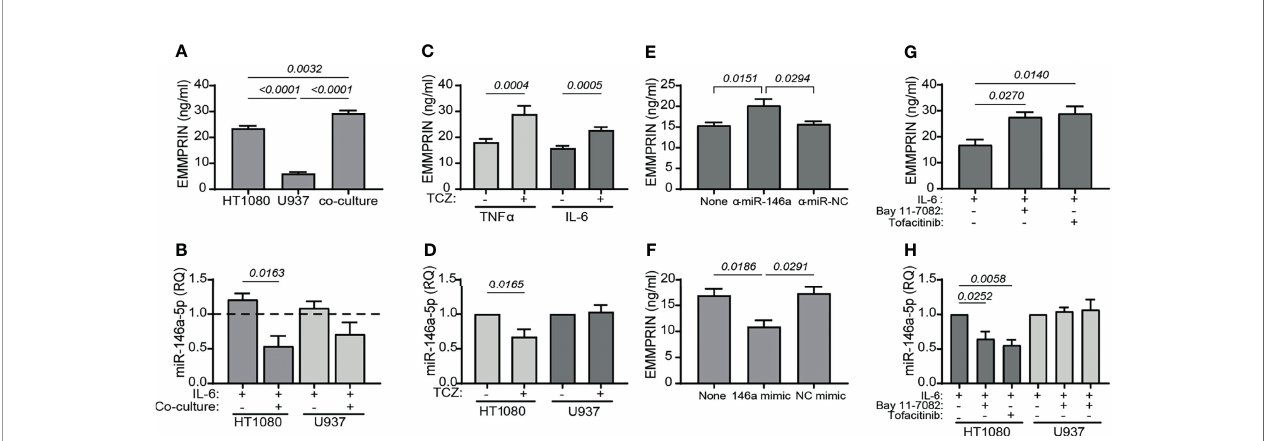
FIGURE 8 | IL-6 affects EMMPRIN and miR-146-5p expression similarly to TNF a . (A, B) HT1080 and U937 cells (3x10 5 cells in 800 m L) were co-cultured for 48h in the presence of recombinant IL-6 (20 ng/ml), and (A) EMMPRIN concentrations or (B) miR-146a-5p expression levels in each cell types were determined. The one- way ANOVA test, followed by the Bonferroni ’ s multiple post-hoc comparison test were used (n=4). (C, D) HT1080 and U937 cells were co-cultured with (C) TNF a (1 ng/ml) or IL-6 (20 ng/ml), or (D) with IL-6 (20 ng/ml) only, and with or without the addition of TCZ (500 m g/ml), and the effects on (C) EMMPRIN concentrations or (D) miR-146a-5p expression levels in each cell type were measured. The one-way ANOVA test, followed by the Bonferroni ’ s multiple post-hoc comparison test were used (n=4). (E, F) HT1080 cells (10 4 cells/well in 100 m L) were transfected with (E) anti-miR-146a-5p or its negative control ( a -miR-NC), or with (F) miR-146a- 5p mimic or its negative control (NC mimic). After transfection, cells were co-cultured with U937 cells with the addition of IL-6 (20 ng/ml), and 48h later the concentrations of EMMPRIN were determined. The one-way ANOVA test, followed by the Bonferroni ’ s multiple post-hoc comparison test were used to assess the effects of the mimic and anti-miR-146a (n=4-5 for each group). Lastly, (G, H) HT1080 and U937 cells (3x10 5 cells in 800 m L) were incubated in co-culture for 48h in the presence of IL-6 (20 ng/ml) and with or without the NF- k B inhibitor Bay 11-7082 (10 m M) or the JAK/STAT inhibitor Tofacitinib (1 m M). The concentrations of (G) EMMPRIN and (H) miR-146a-5p expression levels were measured. The one-way ANOVA test, followed by the Bonferroni ’ s multiple post-hoc comparison test were used to assess the effects of the inhibitors on EMMPRIN and miR-146a-5p expression